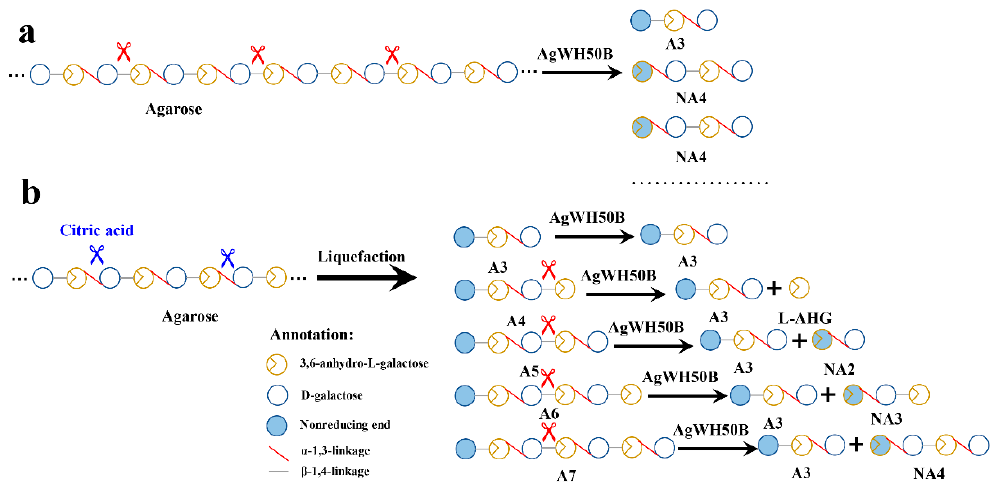
Figure 7. Comparison of simple enzymatic hydrolysis of agarose with our chemical-biological route, to show the reason of A3 accumulation. NA4 production from agarose by enzymatic hydrolysis with NA-forming β -agarase AgWH50B ( a ); A3 production by acid hydrolysis followed by enzymatic hydrolysis with NA-forming β -agarase AgWH50B ( b ).